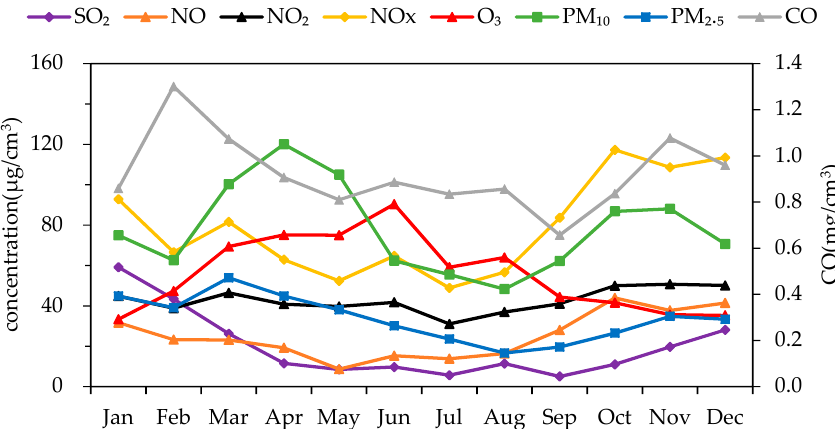
Figure 2. Monthly variation in the concentration of air pollutants in Changchun in 2018.